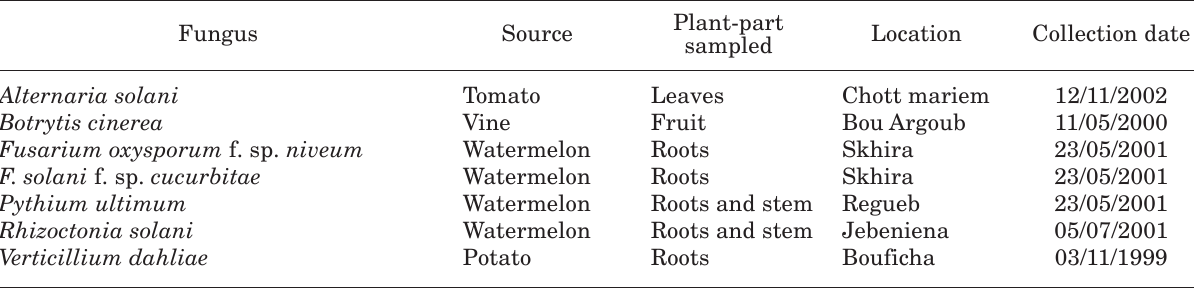
Table 2. Fungal isolates used to test the antifungal activity of extract